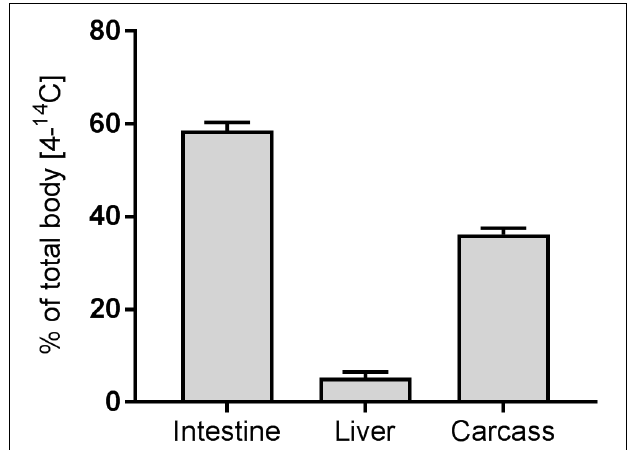
FIGURE 2 | Tissue distribution of [4- 14 C] cholesterol (as percent of total fish [4- 14 C] cholesterol) measured in fish from trial 1. Data presented as mean ± SEM ( n = 49). There were no dietary effects on the tissue distribution of [4- 14 C]